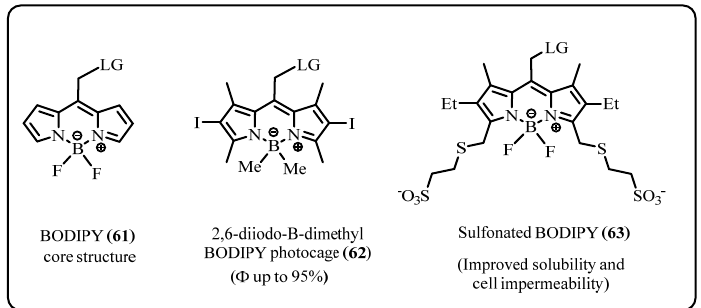
Figure 6. The structures of BODIPY ( 61 ) and its functionalized derivatives ( 62 , 63 ).